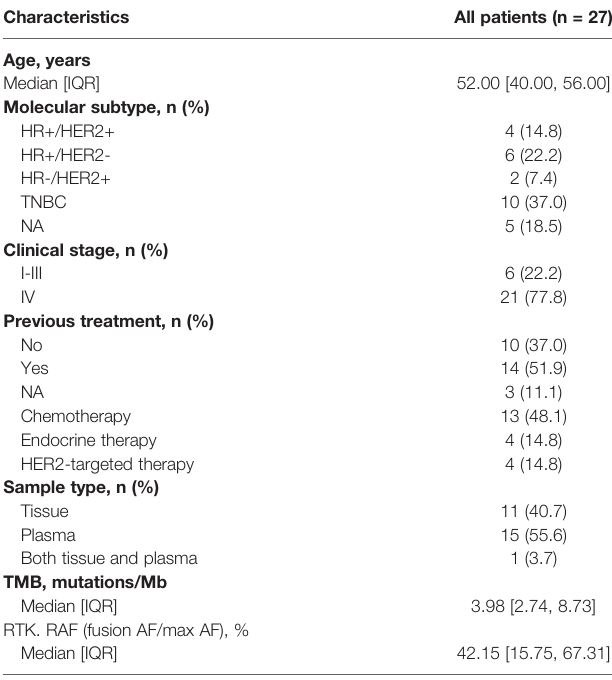
TABLE 1 | Clinicopathological and molecular characteristics of patients.